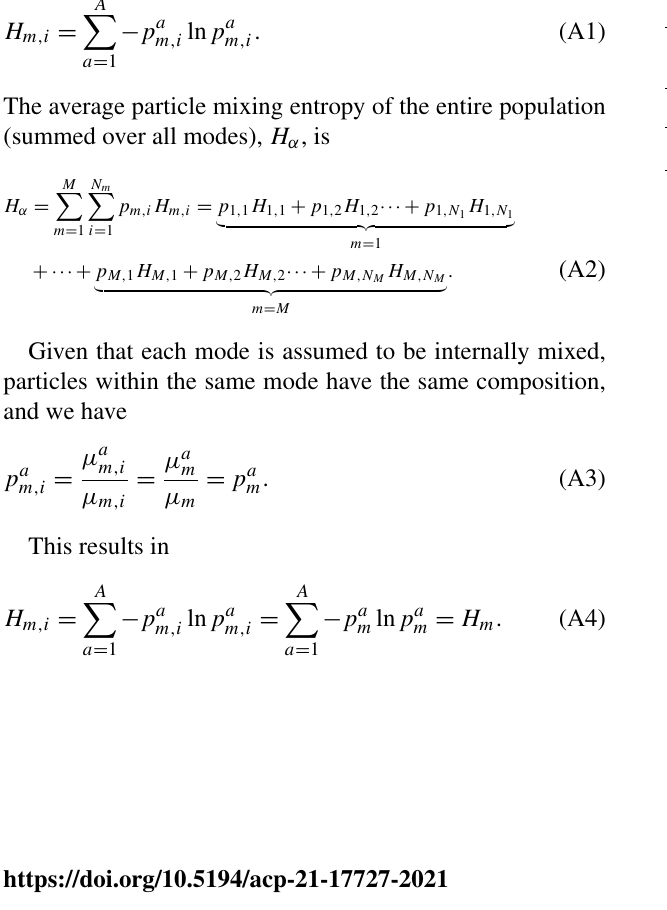
Table A1 details the notation for aerosol mass and mass frac- tions to calculate H α using modal information.